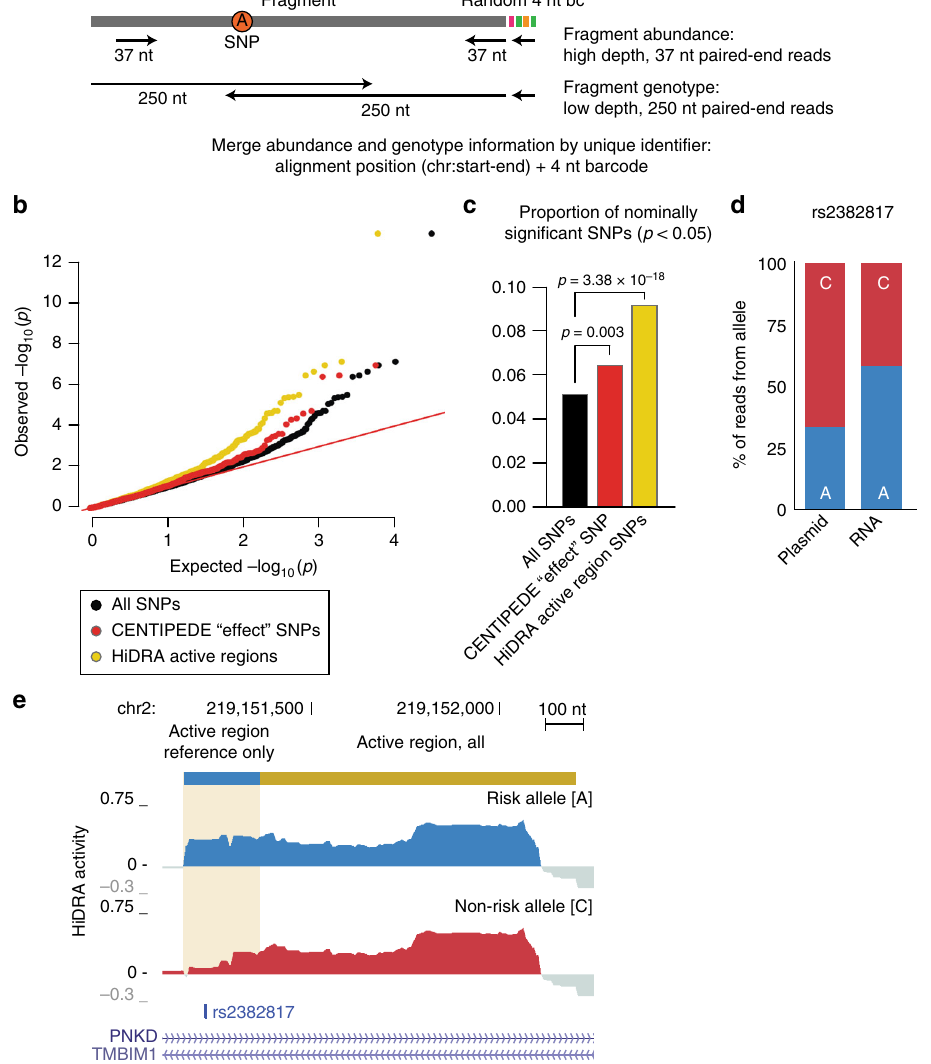
Fig. 6 Identi fi cation of human genetic variants that alter HiDRA activity. a Overview of genotyping approach for HiDRA fragments. HiDRA fragments were originally quanti fi ed at high-depth using 37 nt paired-end reads. At this read length the allele composition of fragments is mostly unobserved. As every HiDRA fragment has a unique identi fi er (genomic alignment position and random 4 nt barcode), long-read re-sequencing of the HiDRA library can assign SNP genotypes to fragments that were previously quanti fi ed for activity using short reads. b q - q plot for allelic imbalance at SNPs covered by HiDRA fragments. CENTIPEDE “ effect ” SNPs were identi fi ed by Moyerbrailean et al. 34 . c “ Effect ” SNPs and SNPs within HiDRA active regions are more likely to be nominally signi fi cant for allelic imbalance. p -values from Fisher ’ s exact test. d The A allele of rs2382817, a SNP associated with in fl ammatory bowel disease, is more active in the HiDRA assay than the C allele. e Alelle-speci fi c HiDRA activity signal tracks for